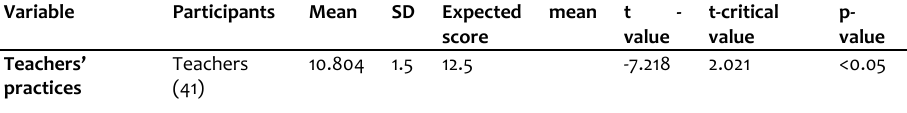
Table 3: Teachers’ practice of peer-led learning in the school Variable